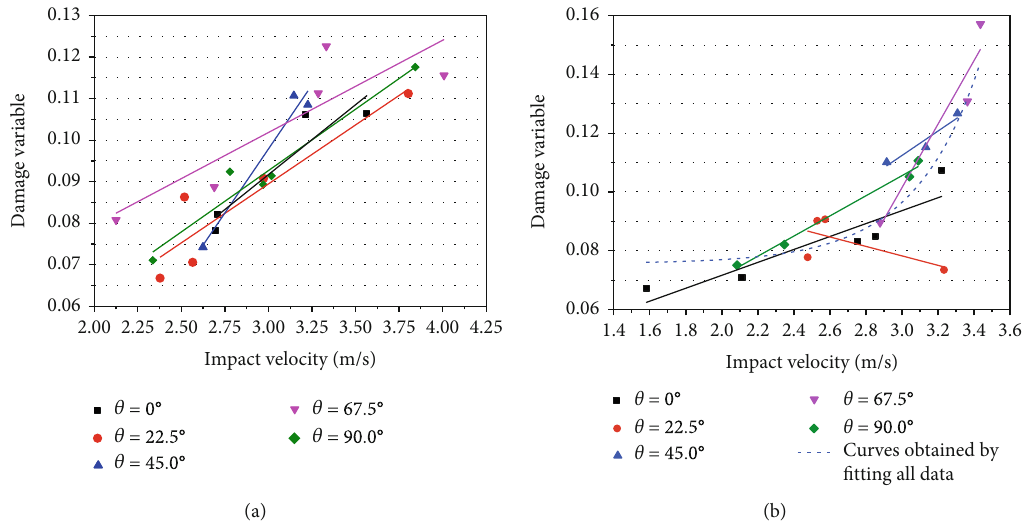
Figure 7: Relationship between damage variable and impact velocity of coal samples.